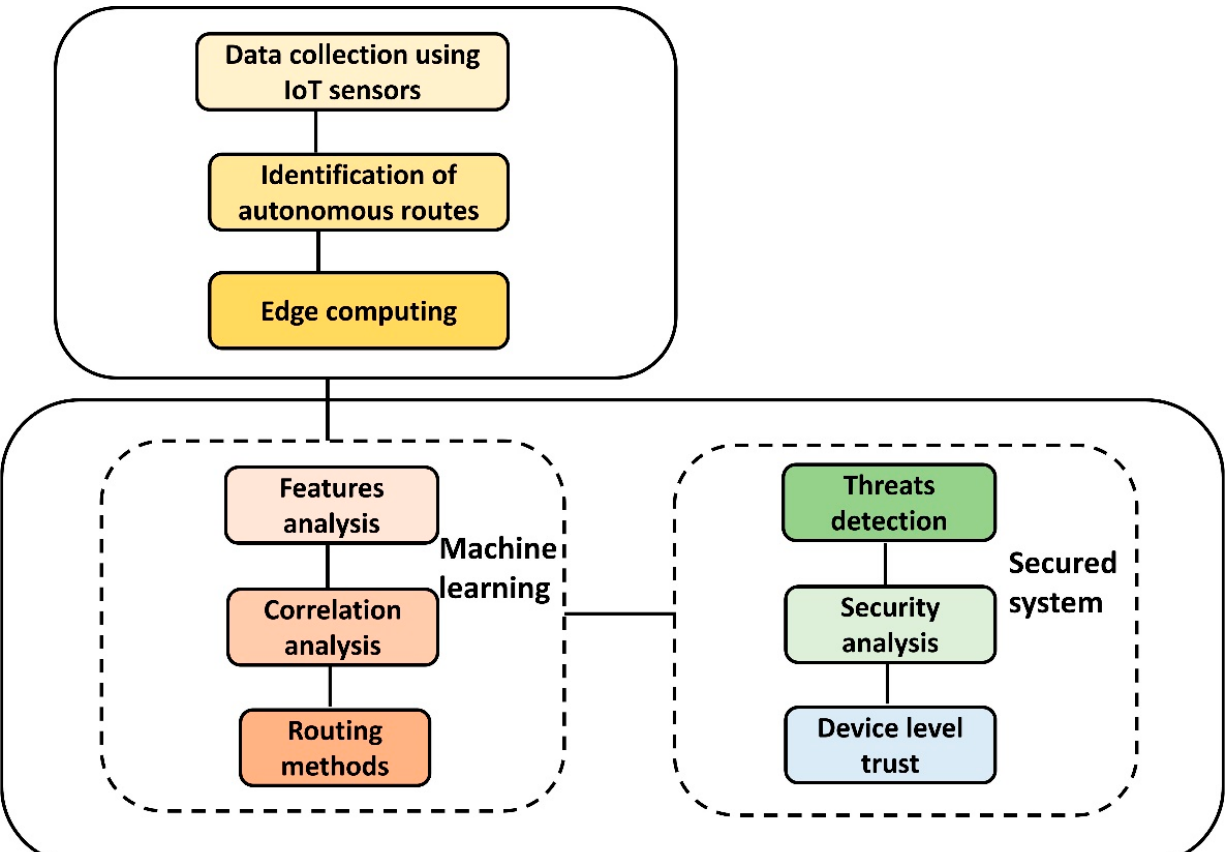
Figure 1. Block diagram of the proposed protocol.